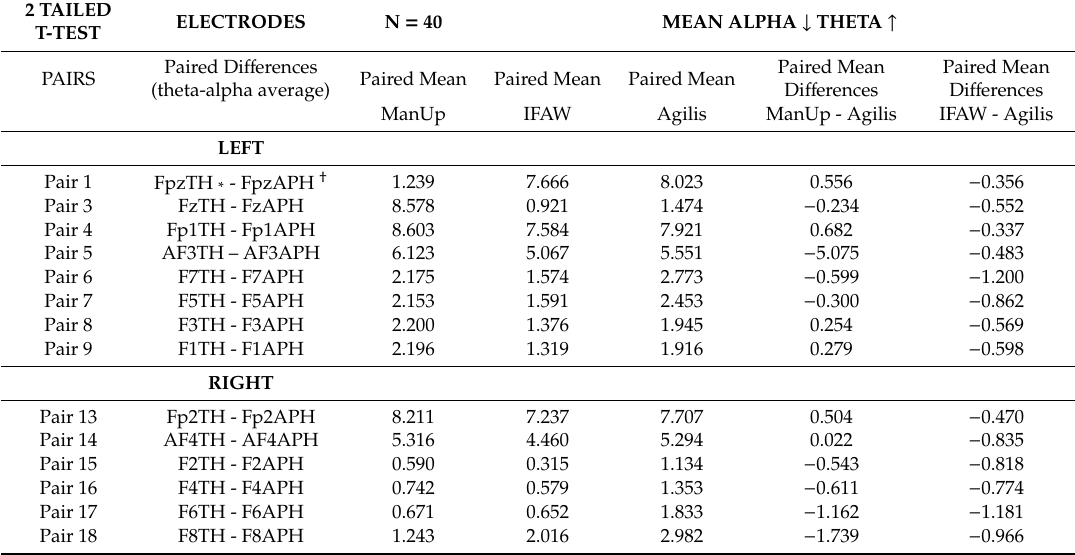
Table4. Summaryof 2-tailedt-test results ofpaireddi ff erencesforfrontal, parietal, andparietal–occipital regions showing theta / alpha synchronisation / desynchronisation (Alpha ↓ Theta ↑ ) (Appendix A).